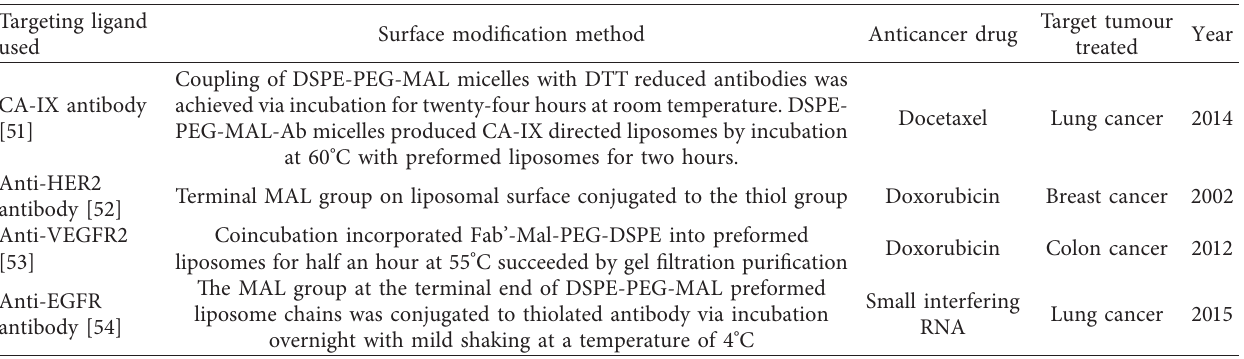
Figure 4: A diagram illustrating the potential for diverse functionalization of liposomes. Conventional liposomes lack surface modifications, or they can be coated with PEG on their surface. Various targeting ligands can be attached for active targeting and multiple targeting ligands can be added to the liposomal surface [24]. Table 1: Liposomes functionalized with specific targeting ligands through various surface engineering techniques for the treatment of solid